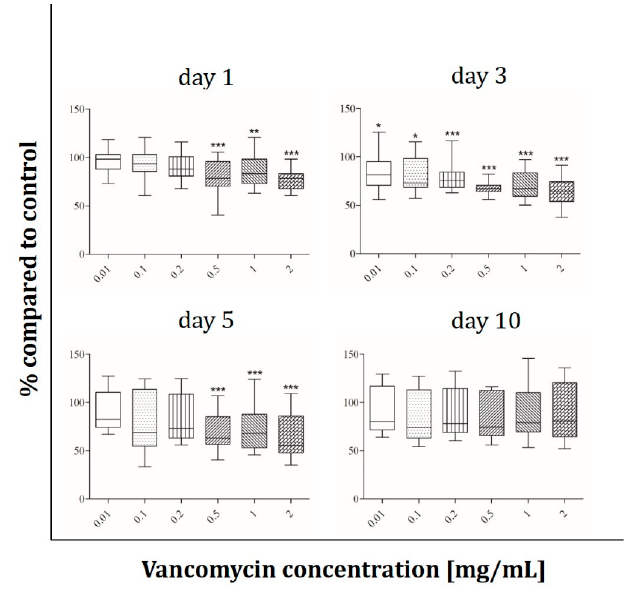
Figure 1. Determination of vancomycin MIC (µg/mL) with Staphylococcus aureus 6538P ( a ) and Staphylococcus aureus 29213 ( b ).